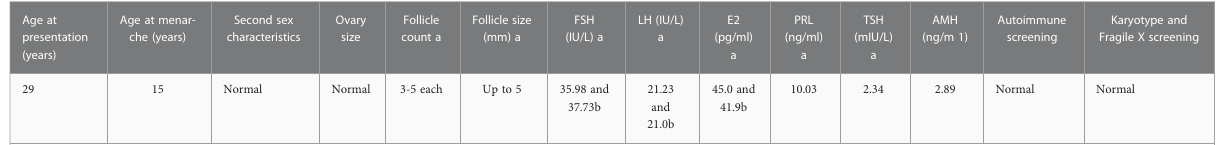
TABLE 1 Clinical characteristics of the